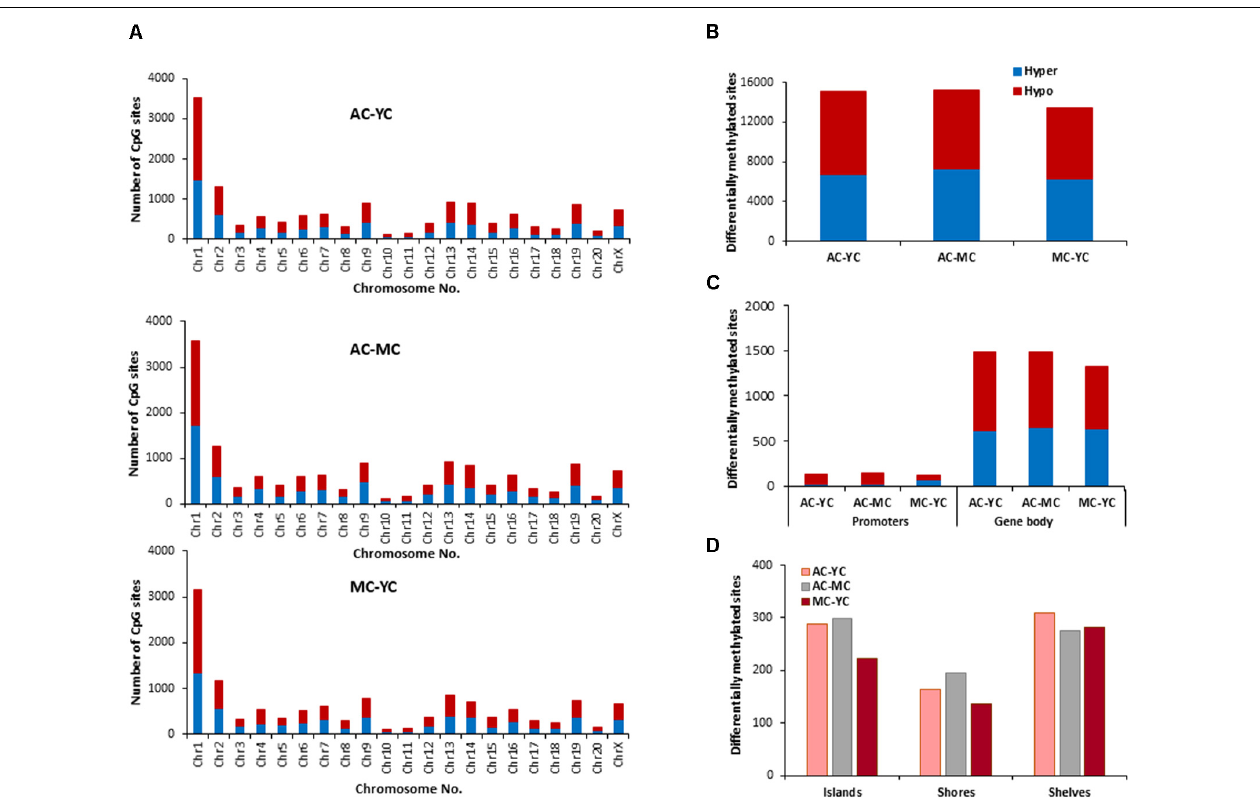
FIGURE 2 | Age-related differences in DNA methylation at CpG sites of control animals. (A) Differentially methylated CpG sites along the chromosome (1–20) including X-chromosome in control groups. The differential methylation was based on a statistical significance of p < 0.01. (B) Total number of differentially methylated CpG sites across the control groups. The red bars denote hypomethylation and blue bar denotes hypermethylation for the older group relative to the younger group. (C) Age differences in the number of differentially methylated CpG sites in promoter and gene body regions. (D) Comparison of the differentially methylated CpG sites across the regulatory regions: islands, shores, and